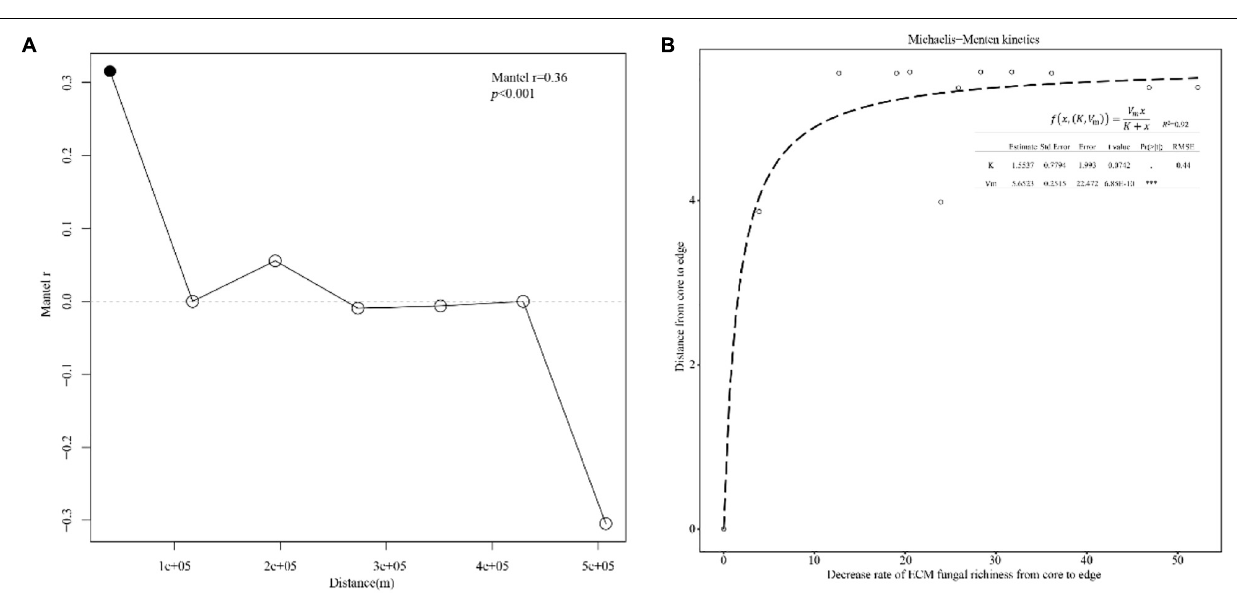
FIGURE 3 | (A) Spatial correlogram between Mantel statistics and distance class index: significant Mantel correlation (black points) indicates spatial correlation. (B) Decrease rate of ECM fungal richness from center to edges. The data were fitted to Michaelis–Menten kinetics, and the dashed line shows a significant non-linear